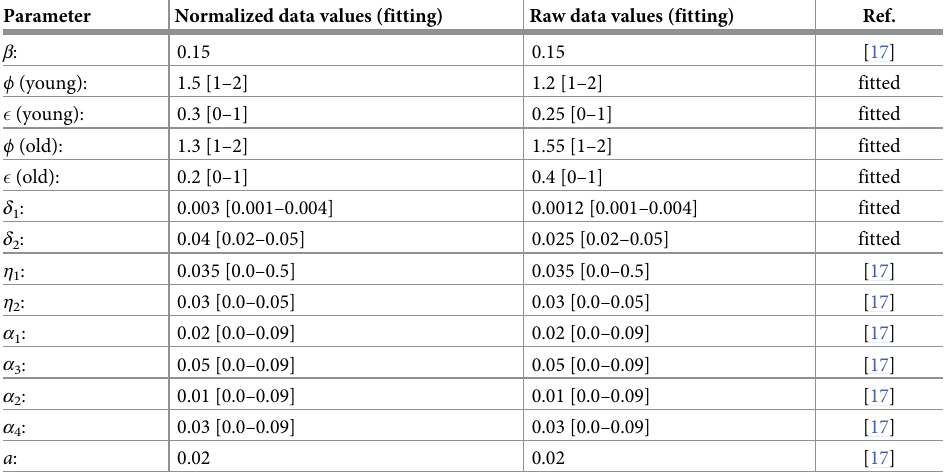
Table 4. Parameters values used for model